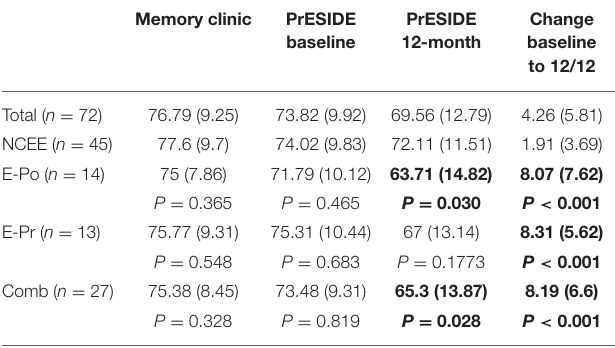
TABLE 3 | ACE-III test scores (mean and S.D) in participants with AD at different time points, with subjects categorized by suspicion of epilepsy, bold figures indicate significant difference ( p < 0.05) when compared to NCEE